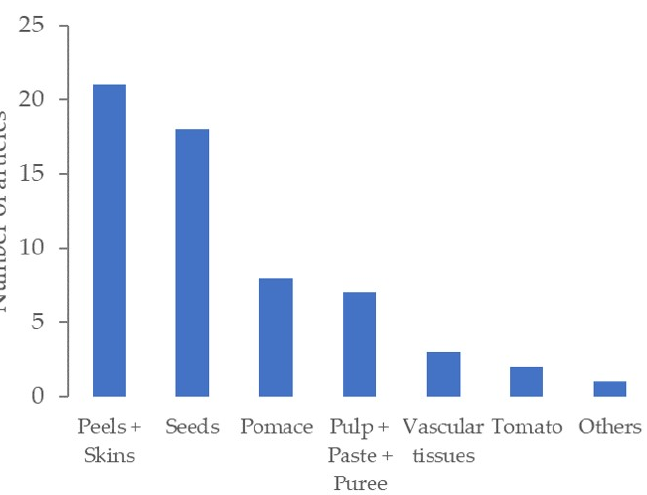
Figure 3. Distribution of research studies over the different morphological parts of tomato plant according to the data collected in Table